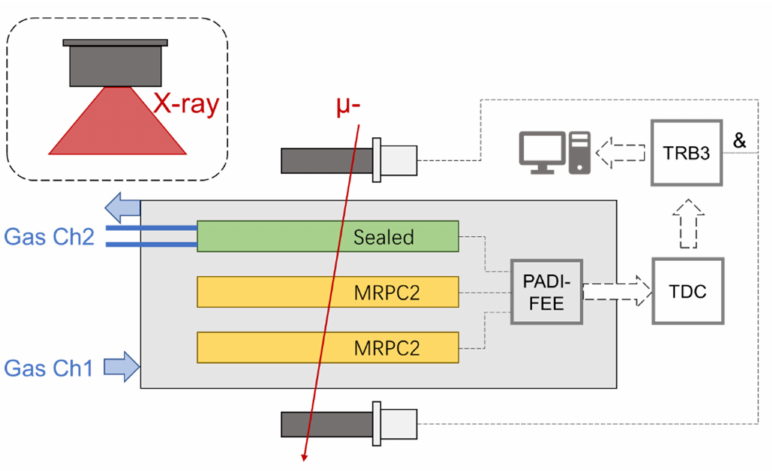
Figure 5. The TRB3 test stand. For the cosmic test, trigger is provided by the coincidence of two scintillators. In the X-ray test discussed afterward, the scintillators are replaced by an X-ray source, and the TDC operates in the free-running mode for the record of counting rate.